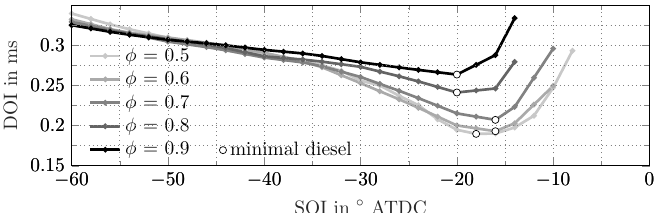
Figure A3. Measured duration of injection (DOI) of Diesel in dependency of the start of injection (SOI) and the equivalence ratio φ . All measurements are conducted at the same center of combustion ( COC = 6 ◦ ATDC) and the same brake mean effective pressure ( p me = 4 bar) at 1500 rpm.